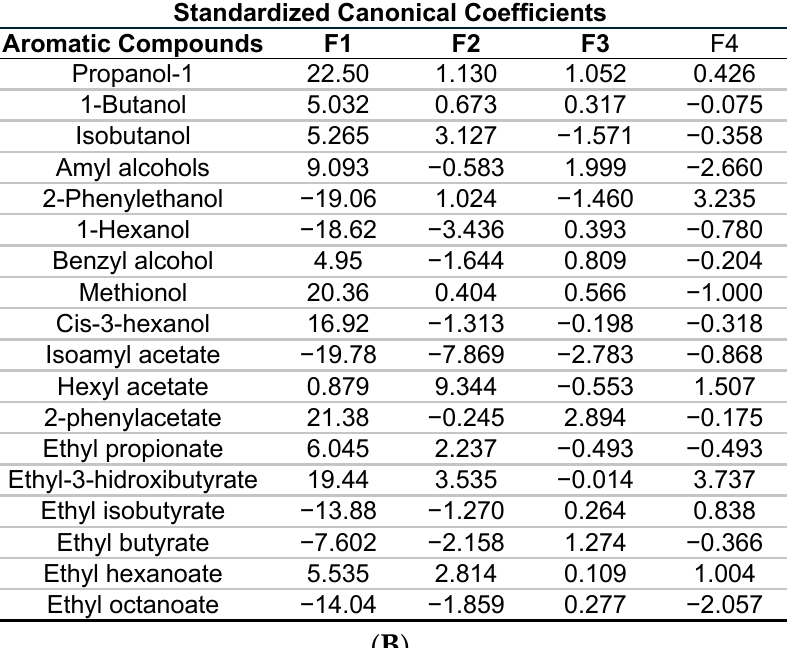
early inoculated with M. pulcherrima (M) and samples early inoculated with a mix of L. thermotolerans